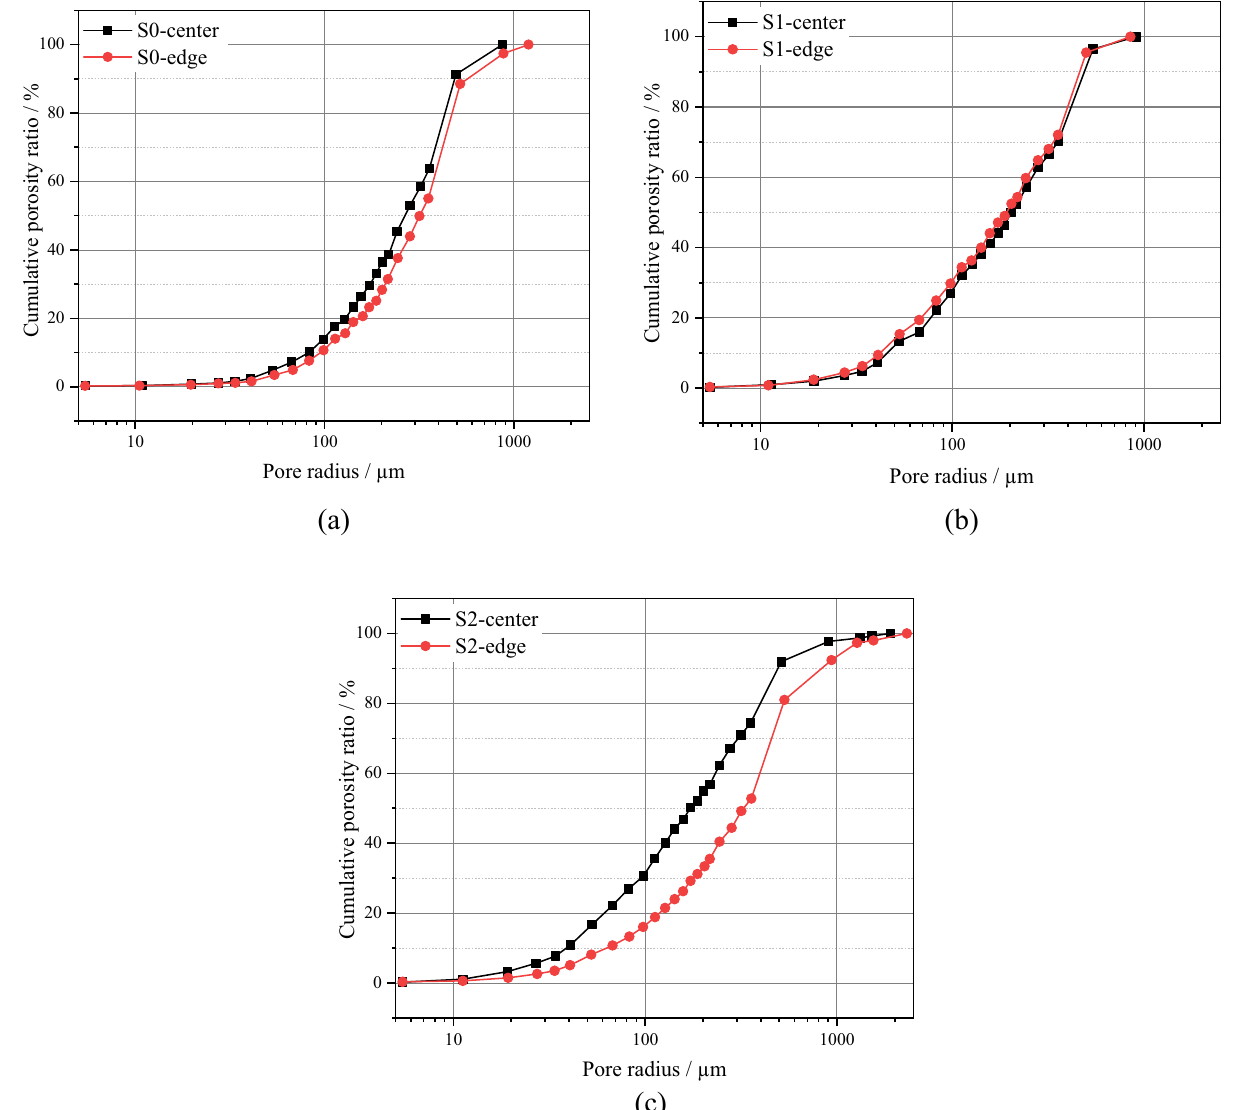
Figure 12: Cumulative porosity ratio of test samples: ( a ) S0 without NS, ( b ) S1 with 1.5% NS, and ( c ) S2 S1 with 3%